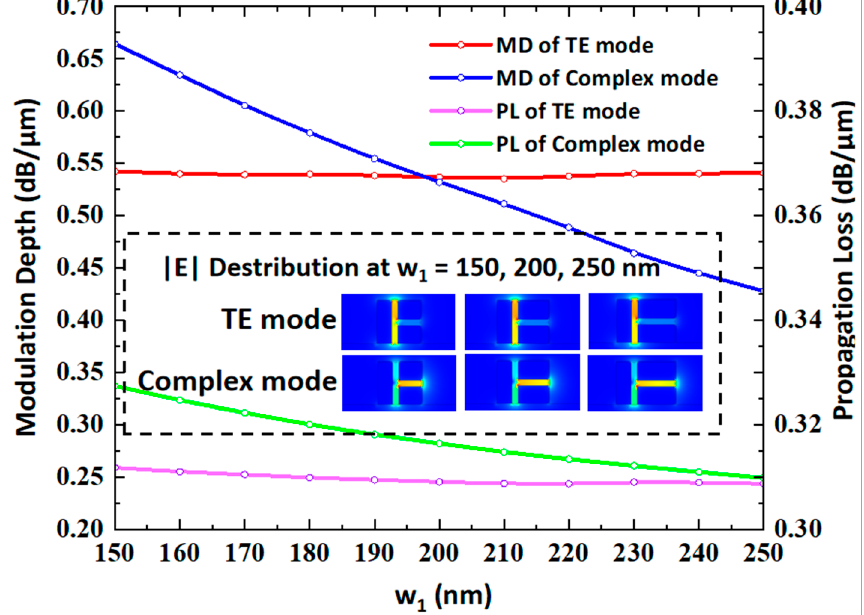
Figure 5. MD and PL of the TE mode and the complex mode as a changing relationship of w 1 .